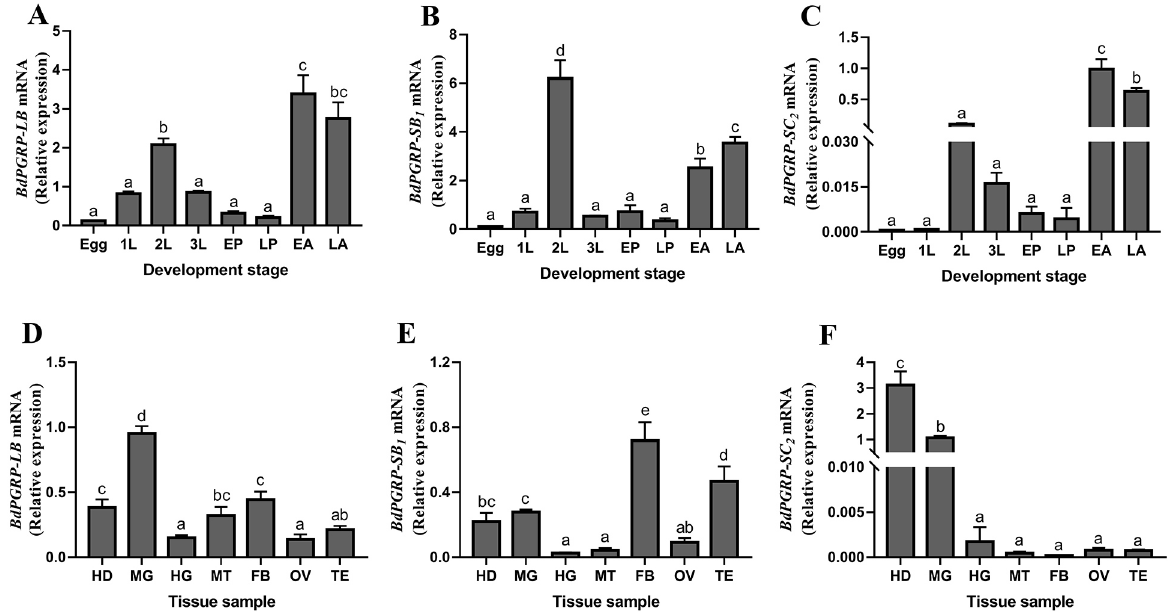
Figure 2. Expression profiles of BdPGRPs in B.dorsalis . ( A ) Relative expression of BdPGRP-LB at dif- ferent development stages. ( B ) Relative expression of BdPGRP-SB 1 at different development stages. ( C ) Relative expression of BdPGRP-SC 2 at different development stages. ( D ) Relative expression of BdPGRP-LB from different tissue samples. ( E ) Relative expression of BdPGRP-SB 1 from different tissue samples. ( F ) Relative expression of BdPGRP-SC 2 from different tissue samples. B. dorsalis was